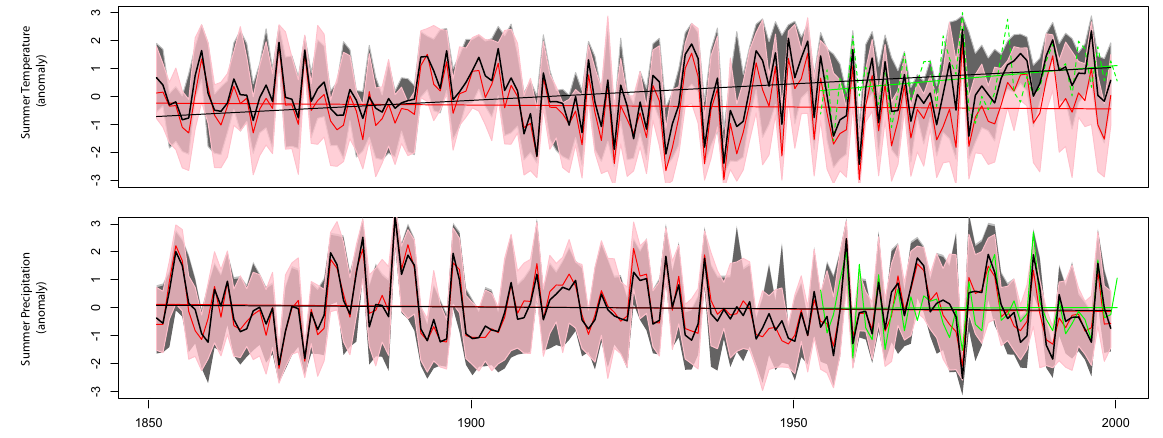
Figure 9. Summer temperature and precipitation reconstructions at Fontainebleau, France, obtained from the inversion of MAIDENiso. Black curves and associated 95% uncertainty range are median reconstructed values obtained when the inversion is constrained by realistic, increasing CO 2 data. The red curve and associated 95% confidence intervals are median reconstructed values obtained when the inversion is forced when CO 2 is fixed at preindustrial levels. Observed climate variability (1953–1999) is in dashed green. Linear lines with corresponding colors were added to each series to evaluate multidecadal trends in reconstructed and observed